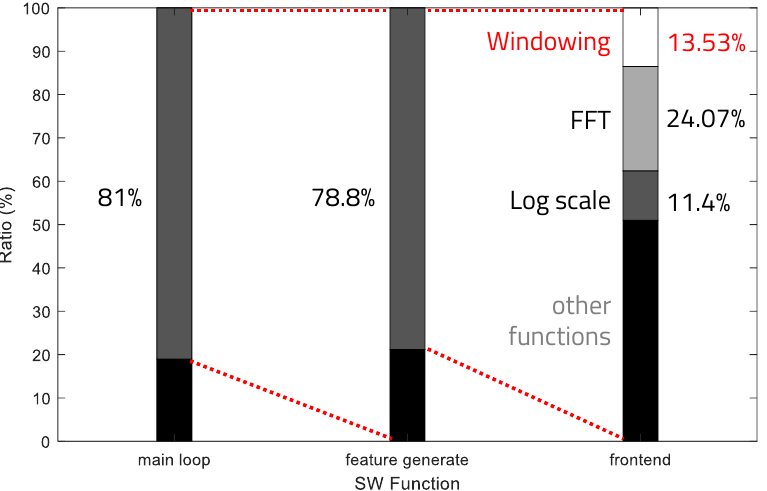
Figure 6. Function proportions of the TinyML application on the MCU edge